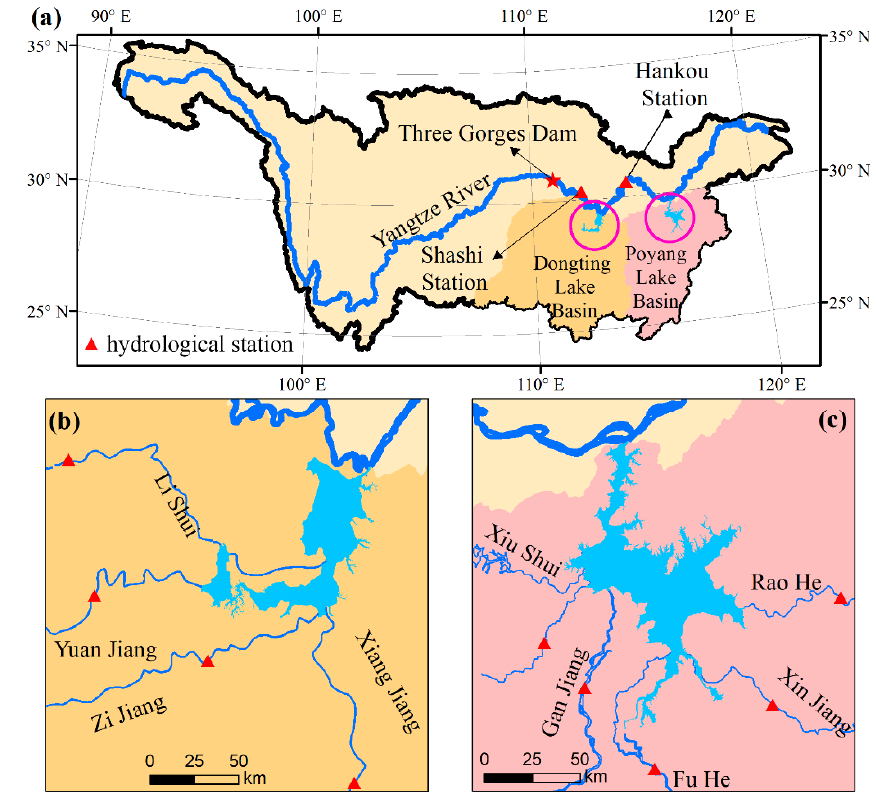
Figure 1. The location of the study area. ( a ) Yangtze River Basin, ( b ) Dongting Lake, and ( c ) Poyang